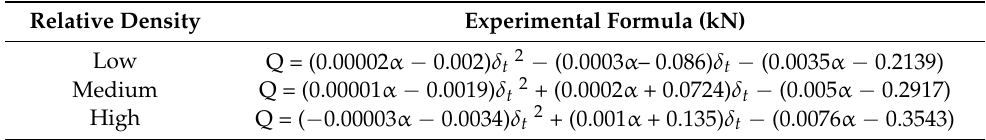
Table 6. An experimental formularization by total